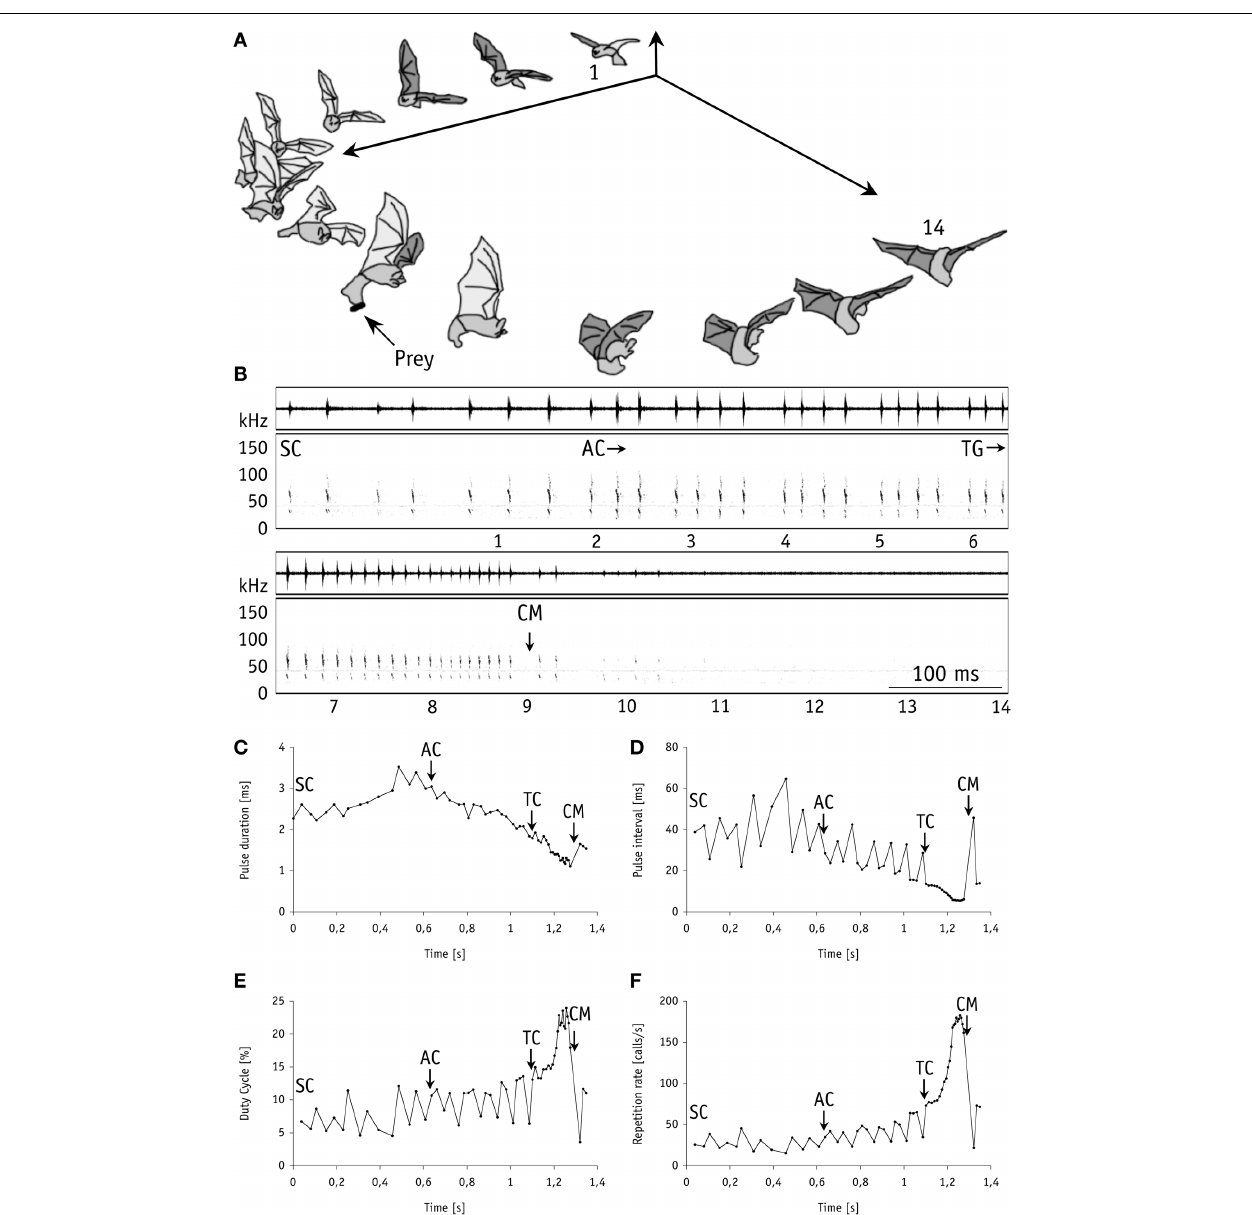
time signal above; numbers below correspond to images of the bat. Plots of call parameters of the same echolocation sequence including (C) pulse duration, (D) repetition rate, (E) pulse interval, and (F) duty cycle. Abbreviations: SC, search calls; AC, start of approach calls; TG/TC, start of terminal group calls; CM, capture of